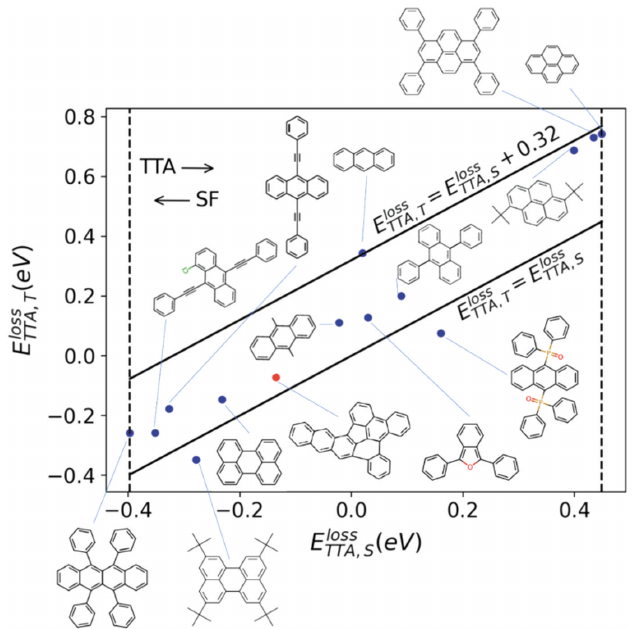
Figure 9 Assessment of compound I (highlighted in red) as a TTA candidate, compared to several known TTA chromophores. The energy release in the singlet pathway, E loss = 2 T 1 (cid:0) S 1 , is plotted on the x axis and the TTA ; S energy release in the competing triplet pathway, E loss = 2 T 1 (cid:0) T 2 , is TTA ; T plotted on the y axis. The dashed line on the left correspond to the E loss TTA ; S of rubrene and the dashed line on the right corresponds to the E loss of TTA ; S pyrene. The region delineated by the two diagonal lines is where most experimentally known TTA chromophores are found in Wang et al.